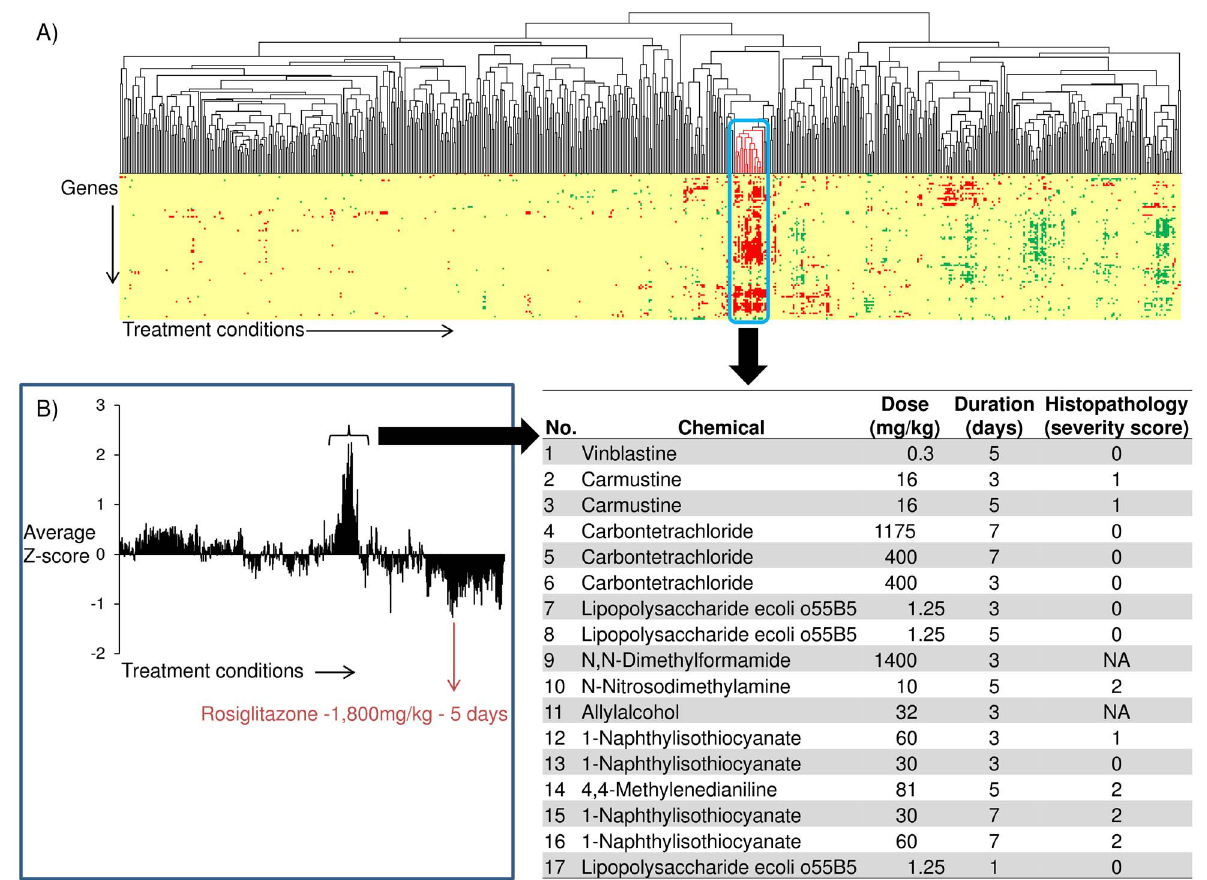
Figure 8. Analysis of genes in liver fibrosis-relevant network module M5. A) Hierarchical clustering of 640 chemical exposures using genes in liver fibrosis-relevant network module M5. The conditions that clustered with four liver fibrosis-producing conditions are highlighted and listed. Genes with Z-scores . 2 are colored in red. Genes with Z-scores ,2 2 are colored in green. Genes with Z-scores between 2 and -2 are colored in yellow. NA in the table represents that histopathological data was not available for that chemical exposure condition. B) Average Z-scores across the genes in module M5 for each of the 640 chemical exposure conditions. doi:10.1371/journal.pone.0112193.g008 were initially identified with grade 2 periportal liver fibrosis carmustine, and allyl alcohol all had conditions within the drug ( Figure 8a ). Most of the 17 conditions in the cluster were matrix dataset that caused periportal fibrosis, but they did not associated with compounds that cause fibrosis. Vinblastine, meet the histopathology grade 2 threshold used for our initial